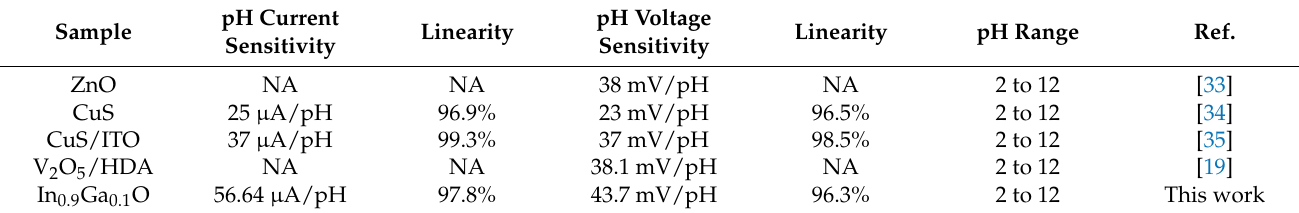
Table 1. Comparison of the sensitivity of the EGFET pH sensors based on various structures and sensing membranes.